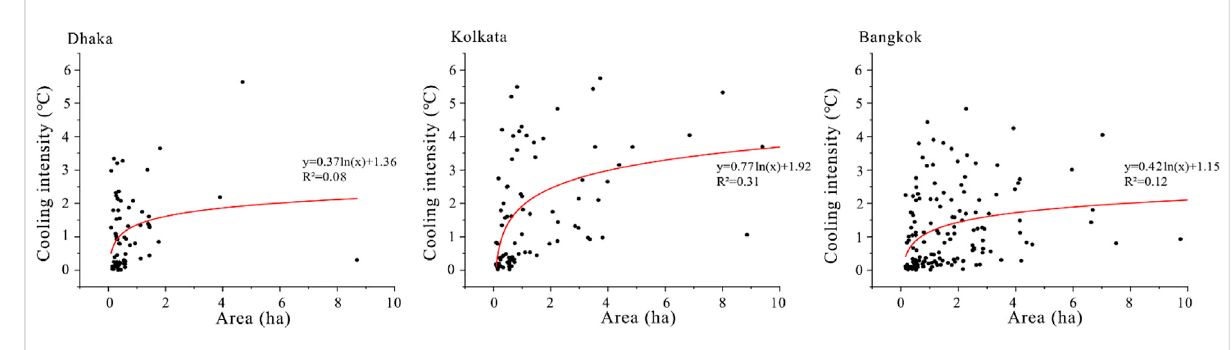
FIGURE 7 Logarithmic regression analysis results in the three megacities.